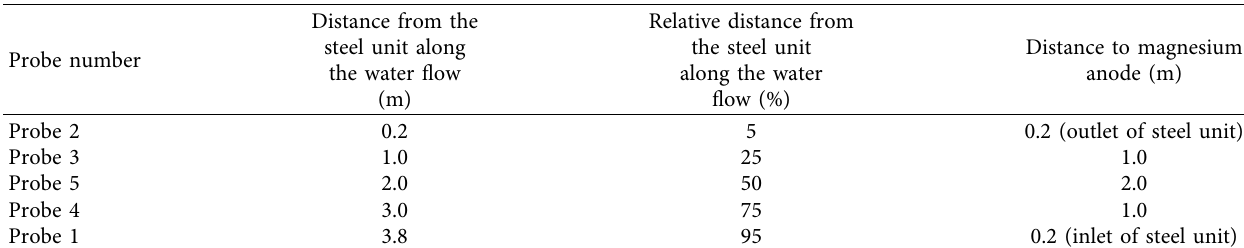
Table 1: Corrosion probe’s location along the water